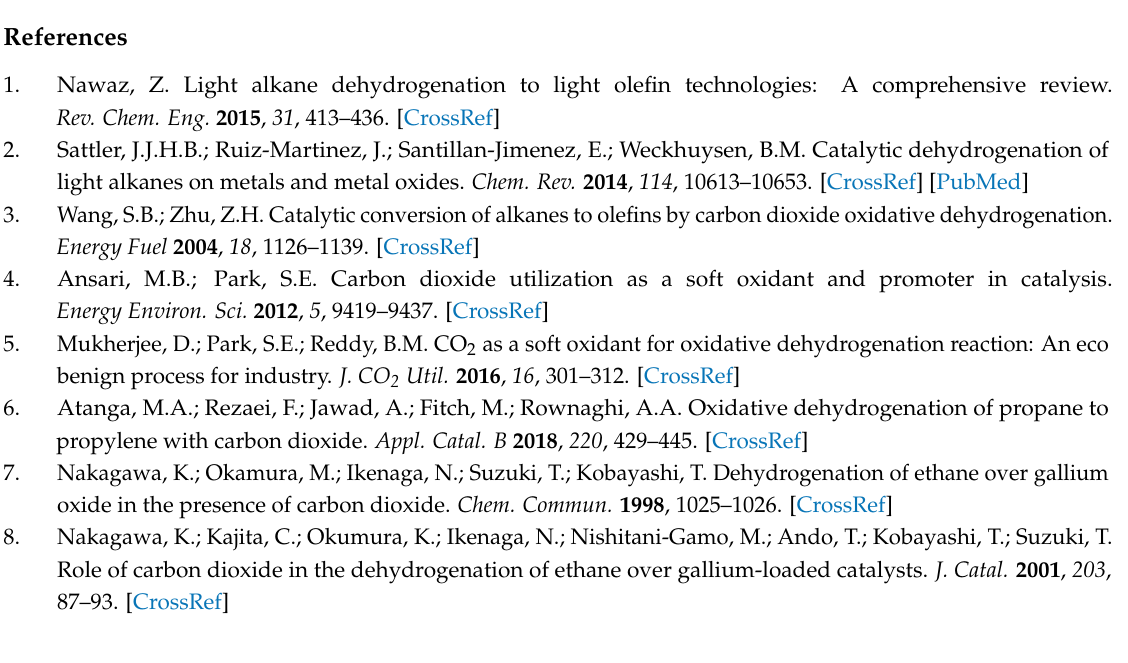
Figure S1: XPS spectra of the Au/Ce 1 − x Mn x O 2 − δ catalysts, Figure S2: Deconvolution of the TPR profiles of the Au/Ce 1 − x Mn x O 2 − δ catalysts, Figure S3: Raman profiles of the spent Au/Ce 0.9 Mn 0.1